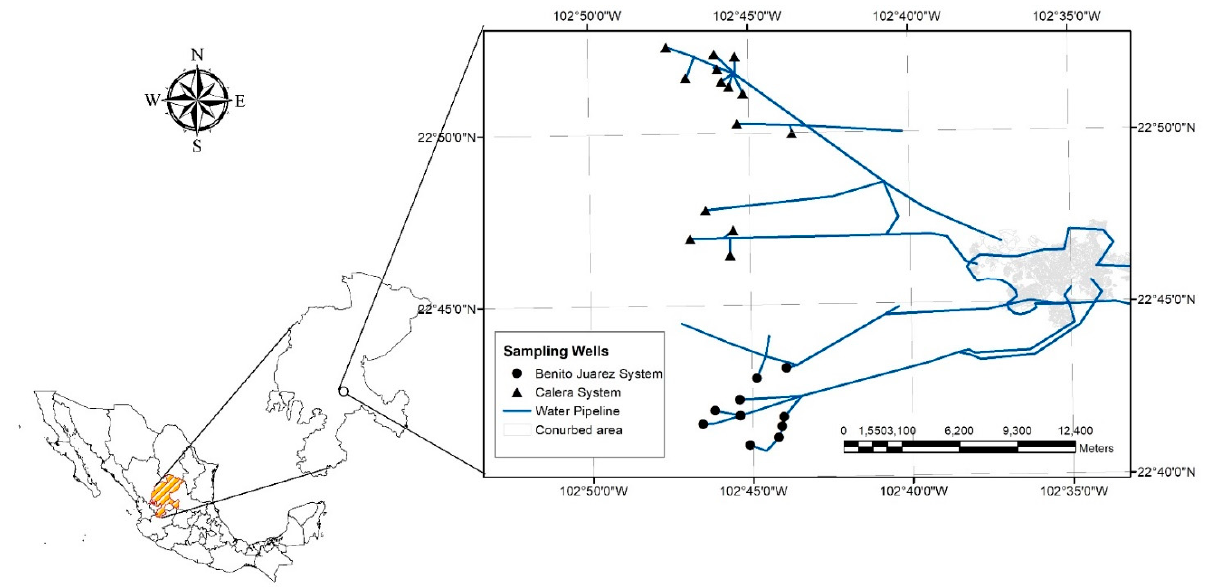
Figure 1. Water distribution system of the Zacatecas conurbation area.